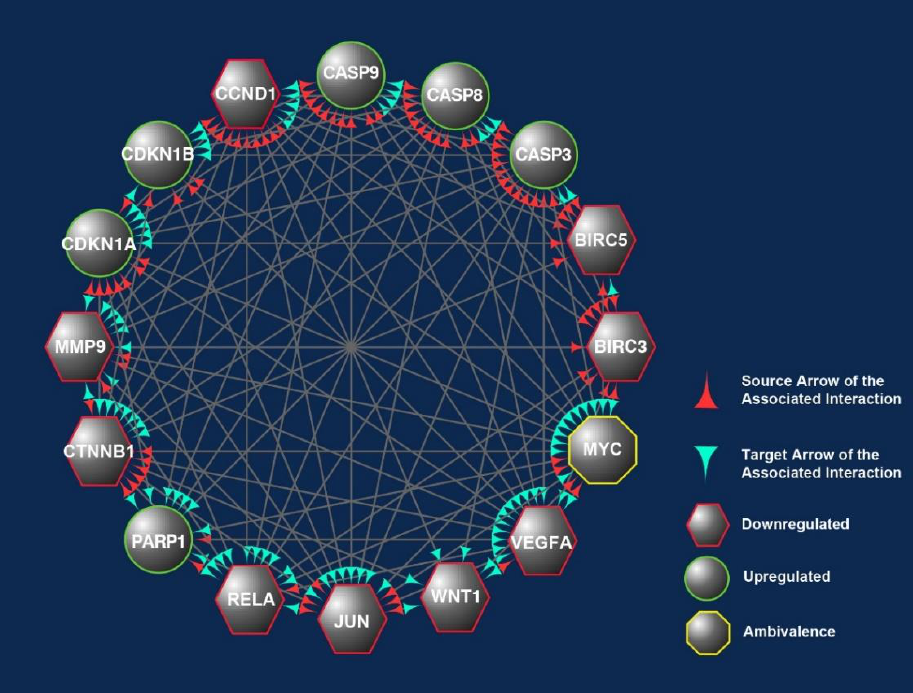
Figure 7. The overlapped targets of the 16 candidate biomarkers (CBs) identified in this study were populated according to their engagements using Cytoscape, an online bioinformatics tool. The protein–protein interactions (PPIs) between these CBs formed a prominent network. The CBs in the hexagons and circles are significantly downregulated or upregulated in human CRC exposed to γT3 or δT3. In contrast, the CB in the octagons is a biomarker that did not show significant changes. The green and red arrowheads reflect the interactions between these CBs. The red arrowheads indicate source CBs protein that can exert stimulatory (circles) or inhibitory (hexagons) or no effects (octagons) on target CBs (green arrowheads).